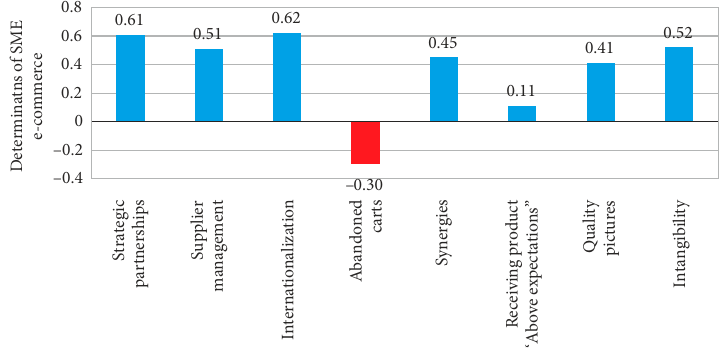
Figure 8. Multi-cluster determinants’ impact on determinants of SME e-commerce